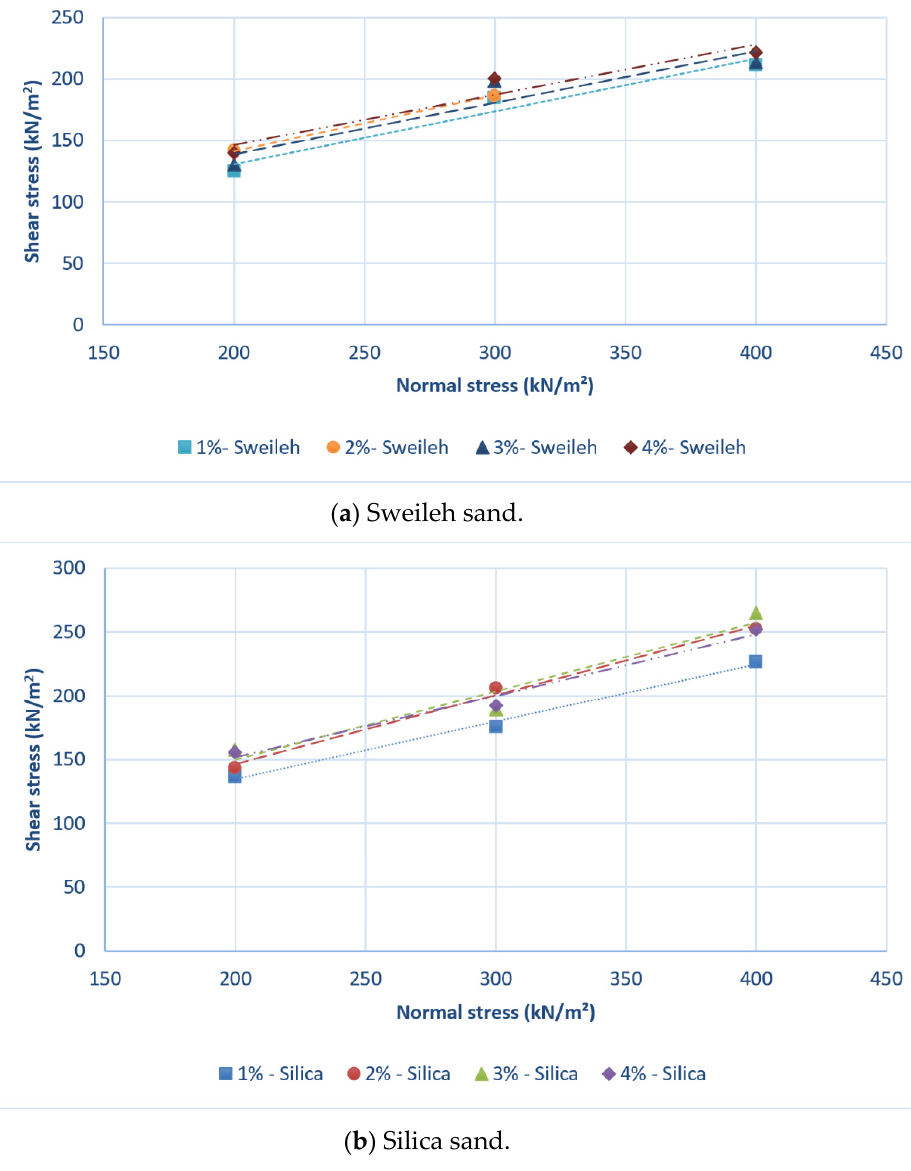
Figure 9. Shear failure envelopes for ( a ) Sweileh, and ( b ) silica sandy soils using various amounts of bentonite clay.